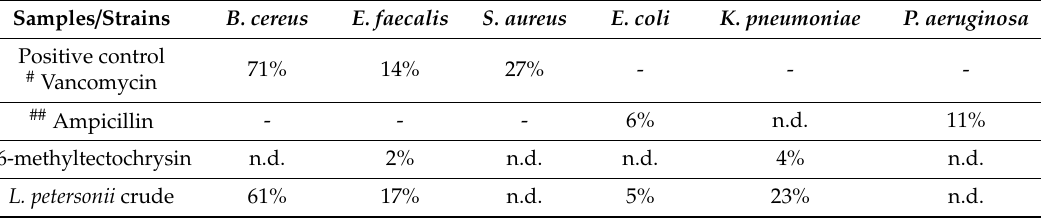
Table 3. Antimicrobial Activities of 6-methyltectochrysin and L. petersonii Crude Extract. Samples /